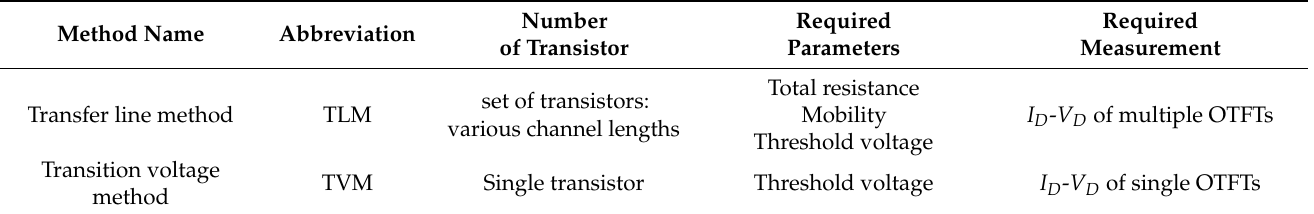
Table 2. Comparison summary of extraction methods of the contact resistance used in this